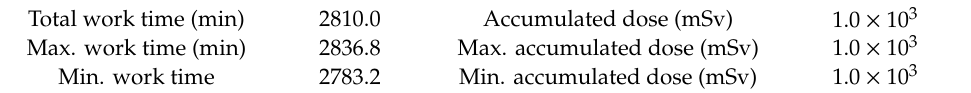
Table 11. Work time and estimated dose for the segmentation of the active part.